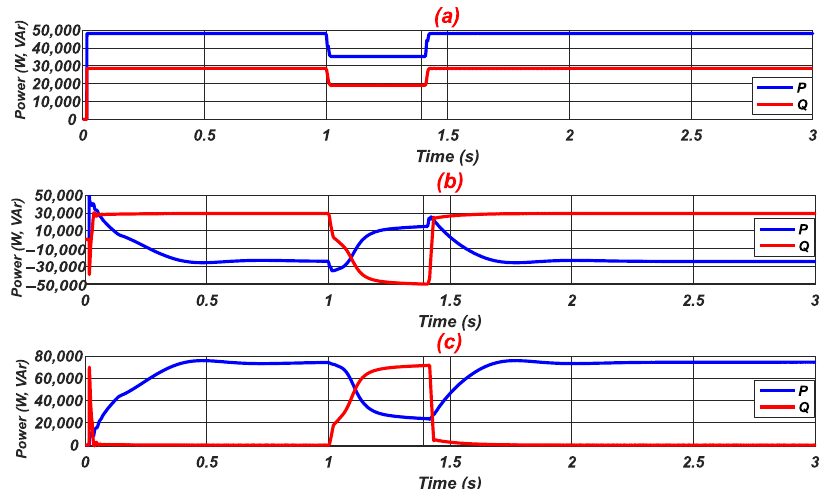
Figure 12. Active and reactive power measured at ( a ) B_12 without GCPVS, ( b ) B_12 with GCPVS, ( c ) GCPVS output terminal.